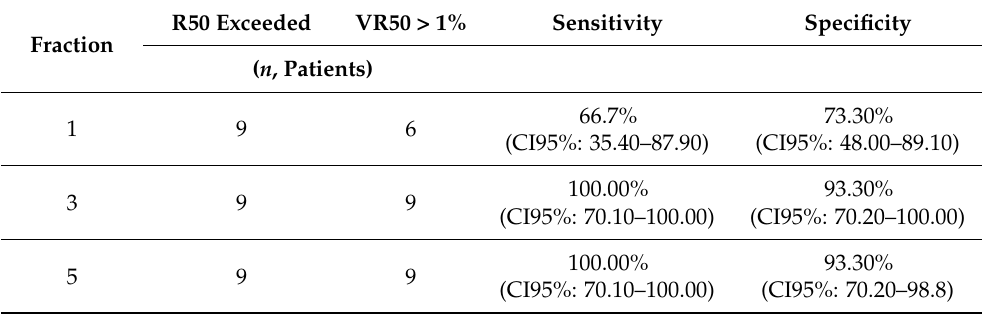
Table 2. Prognostic evaluation of R50 exceeded for VR50 > 1% subgroup analysis in first fractions. R50 Exceeded VR50 > 1% Sensitivity Fraction